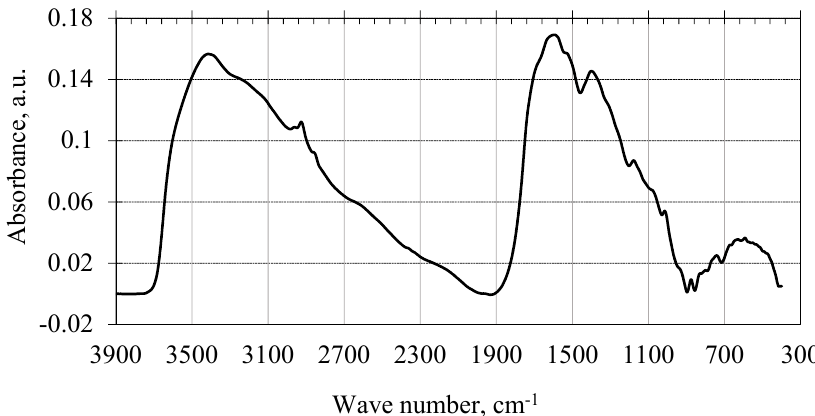
Figure 8. IR spectrum of the product of the interaction of 1,3,5-trioxybenzene with 2-furaldehyde in an alkaline medium.